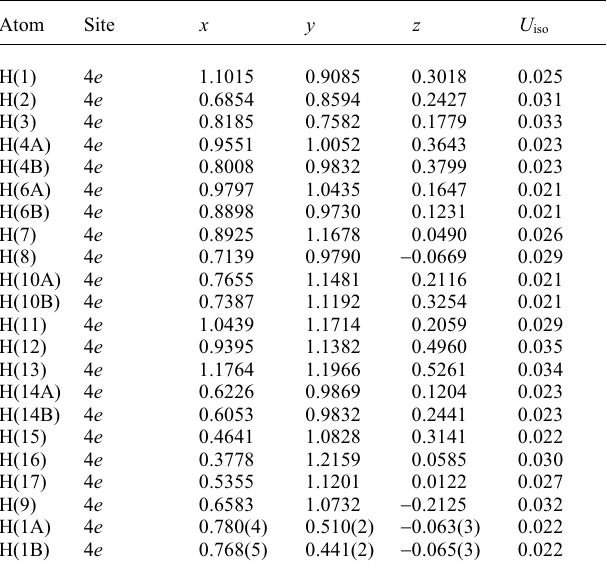
Table 2. Atomic coordinates and displacement parameters (in Å 2 )